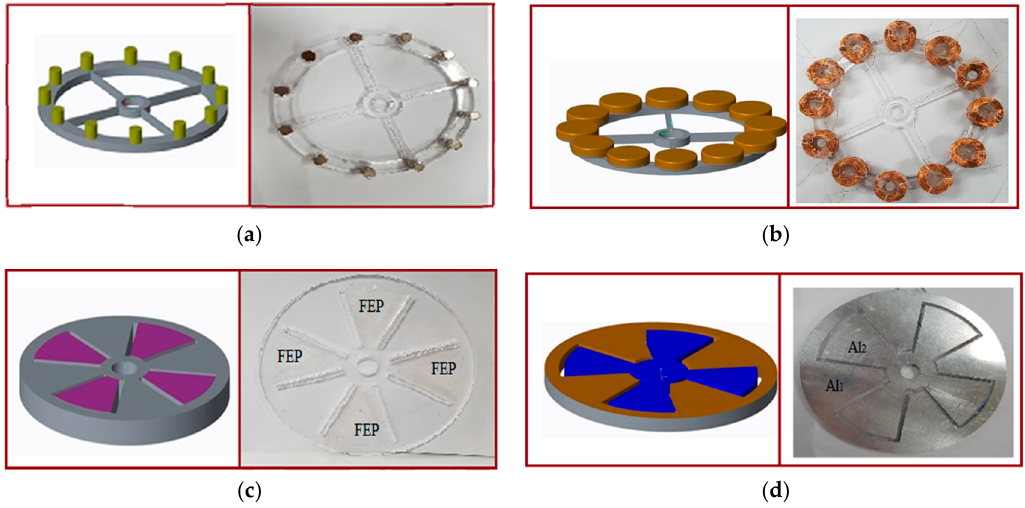
Figure 1. Schematic diagram and fabricated design of the hybridized nanogenerator (NG): ( a ) rotor part of the electromagnetic generator (EMG); ( b ) stator part of the EMG; ( c ) rotor part of the triboelectric nanogenerator (TENG); and ( d ) stator part of the TENG. FEP: fluorinated ethylene propylene.